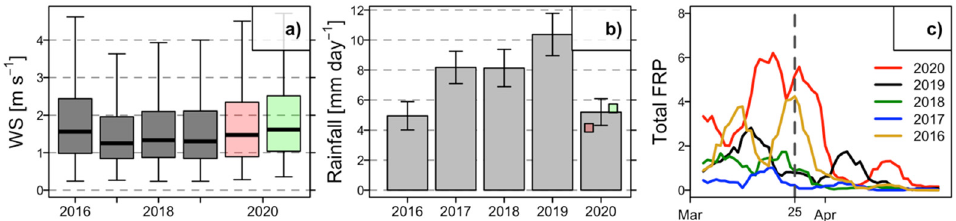
Figure 3. ( a ) Boxplots of wind speed (WS) for March–April 2016–2019 (gray) and the 2020 periods of interest in colors; ( b ) mean daily rainfall rate for March–April in bars (with ±1 standard error), and the Fire (pink) and Lockdown (green) periods; ( c ) daily total FRP (in GW) during March–April for 2016–2020 (7-day moving averages).